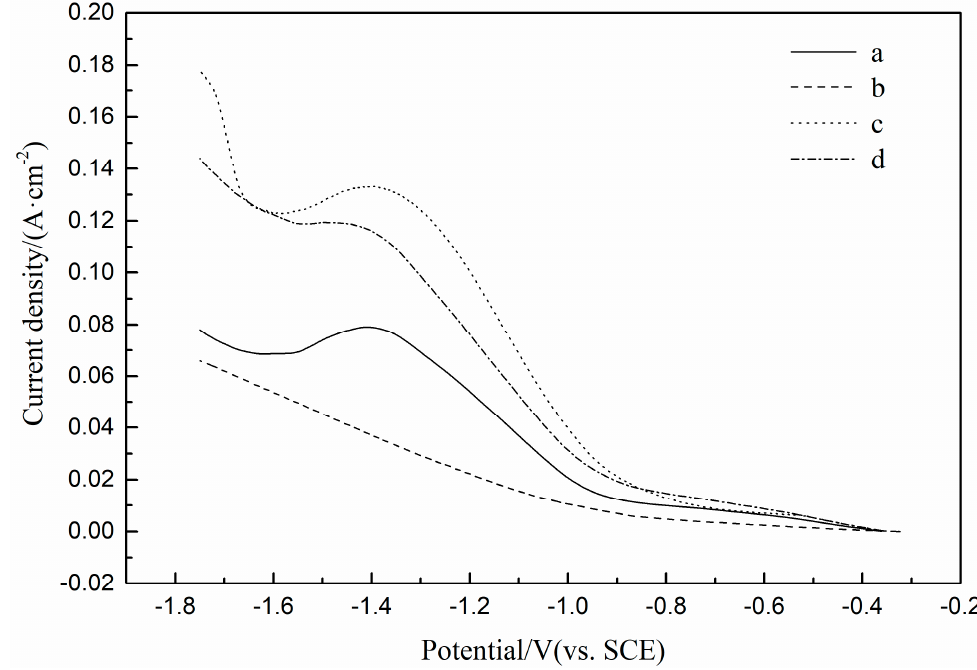
Figure 2. LSV curves of Pt electrode in H 2 SO 4 solution (pH=3): (a) 0.1M FeSO 4 , (b) 0.1M NiSO 4 , (c) 0.1M FeSO 4 and 0.1M NiSO 4 , (d) arithmetic summation of curves a and b.